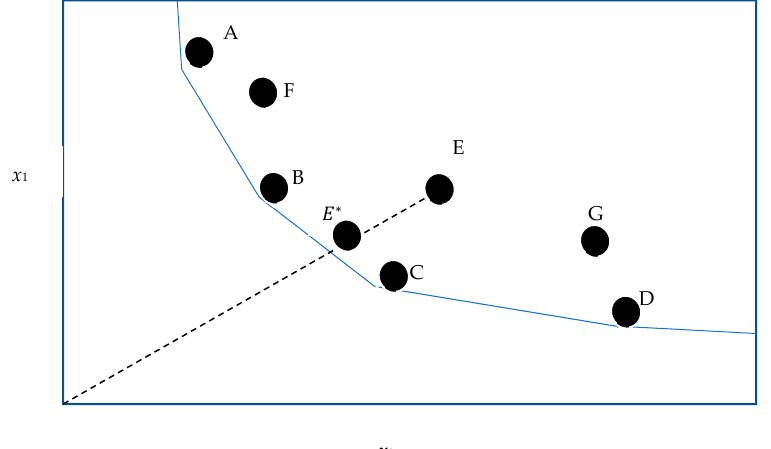
Figure 4. Efficiency boundary.